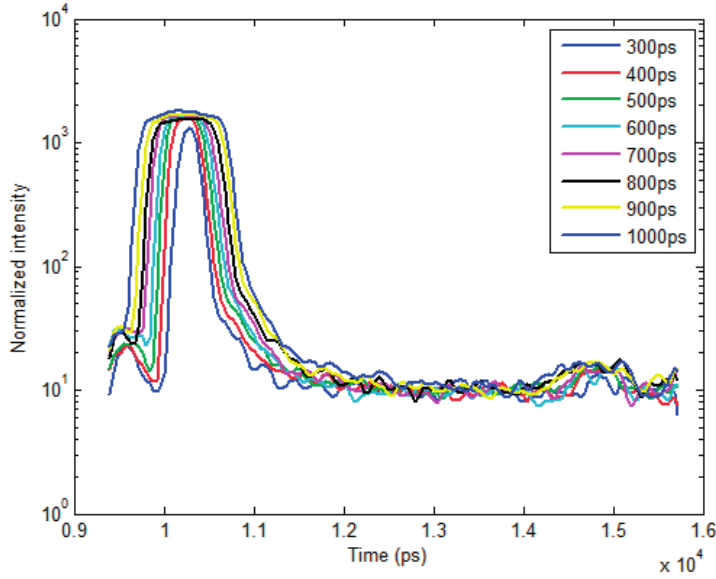
Figure 1. Experimental IRFs acquired from our wide-field imager at each gate width tested in this